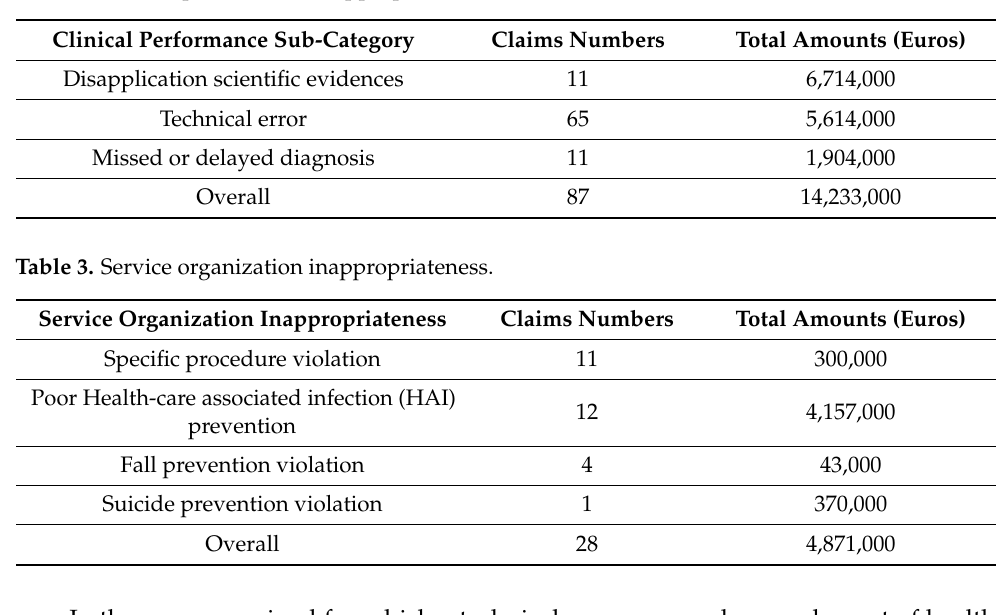
Table 2. Clinical performance inappropriateness.